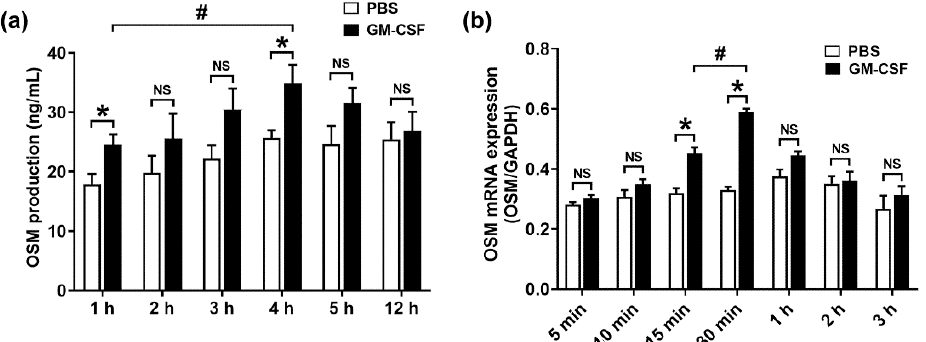
Figure 1. Production and mRNA expression of OSM in neutrophil-like dHL-60 cells. (a) dHL-60 cells (5 × 10 5 ) were stimulated with GM-CSF (5 ng/mL). OSM levels were measured with the ELISA method. (b) dHL-60 cells (1 × 10 6 ) were stimulated with GM-CSF (5 ng/mL). OSM mRNA levels were measured with the real-time PCR method. PBS—PBS-treated and unstimulated cells; GM- CSF—PBS-treated and GM-CSF-stimulated cells. Data are presented as the mean ± S.E.M. of three independent experiments. * p < 0.05 vs. the PBS-treated and unstimulated cells. # p < 0.05 vs. the indicated group. NS, not significant.